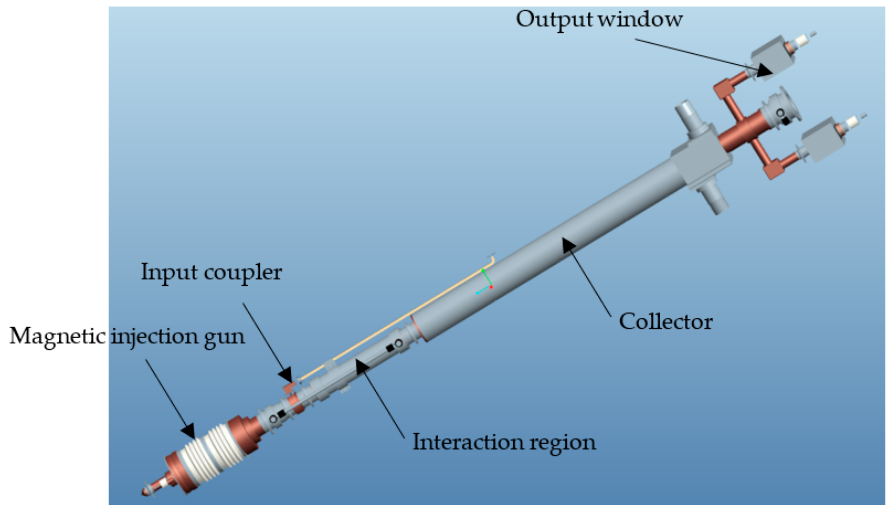
Figure 4. Schematic of the W-band TE 02 mode gyro-TWT.